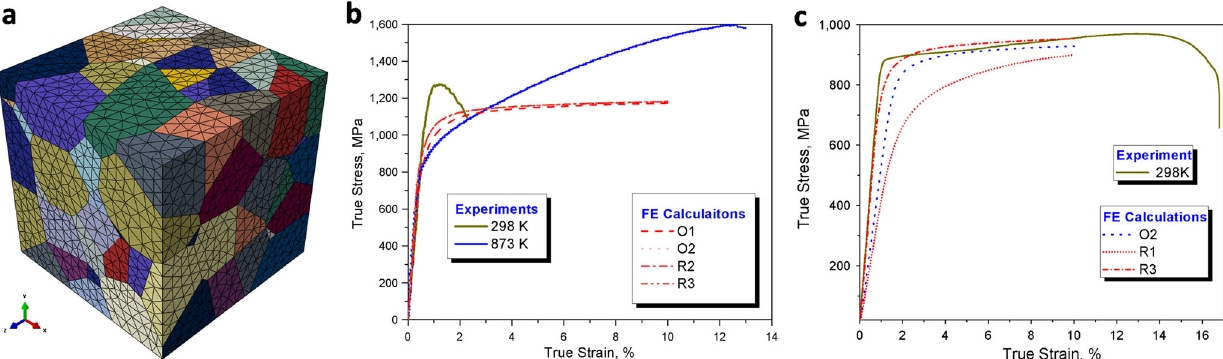
Fig. 5 The polycrystal structure and the predicted stress – strain curves via the crystal plasticity fi nite-elements calculations. a The morphology of utilized polycrystal structure represented by Poisson Voronoi tessellations. b – c The predicted stress – strain curves of various con fi gurations of MoNbTaW and HfZrTiNb,